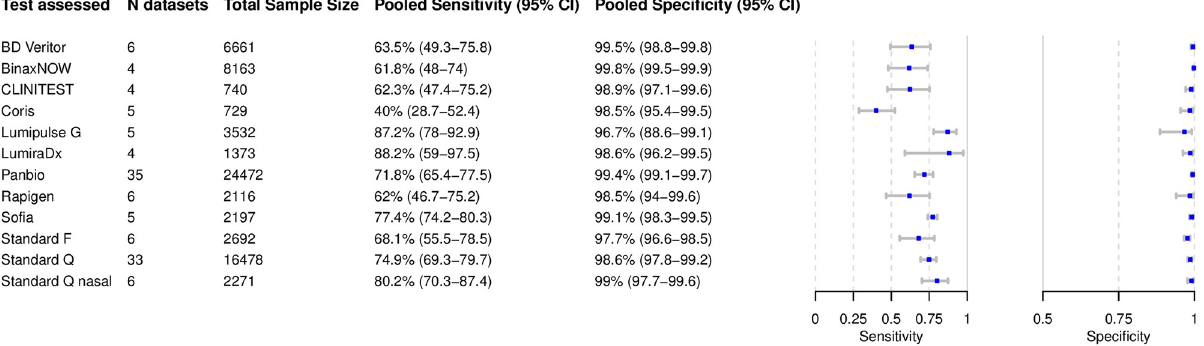
Fig 4. Bivariate analysis of 12 antigen rapid diagnostic tests. Pooled sensitivity and specificity were calculated based on reported sample sizes, true positives, true negatives, false positives, and false negatives.